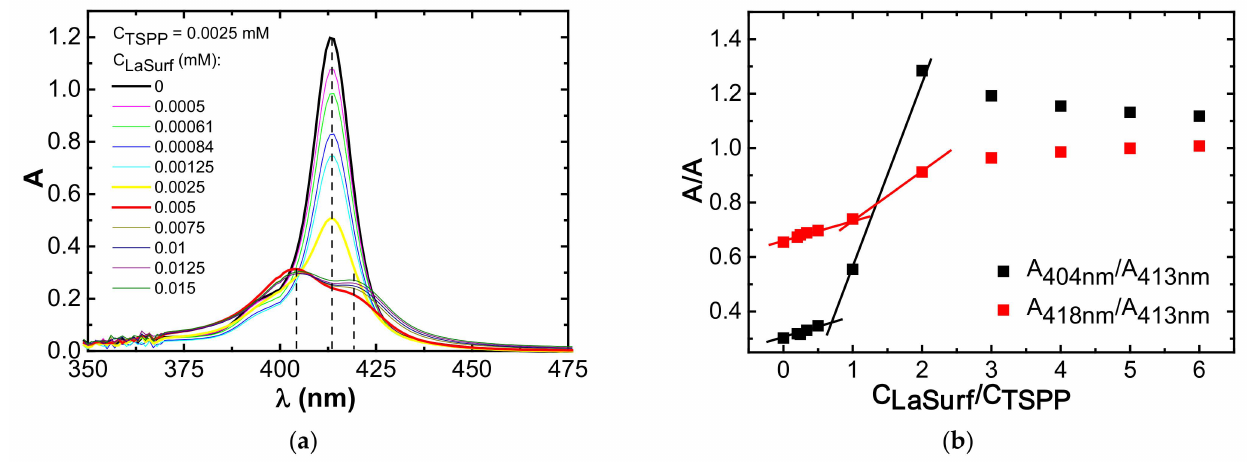
Figure 2. ( a ) Soret region of the absorption spectra of TSPP in the absence and presence of var- ious amounts of LaSurf; ( b ) corresponding dependences of the ratio of absorption intensities (A 418nm /A 413nm , A 404nm /A 413nm ) on the LaSurf fraction in a mixture with TSPP (H 2 O, 25 ◦ C, 1 cm